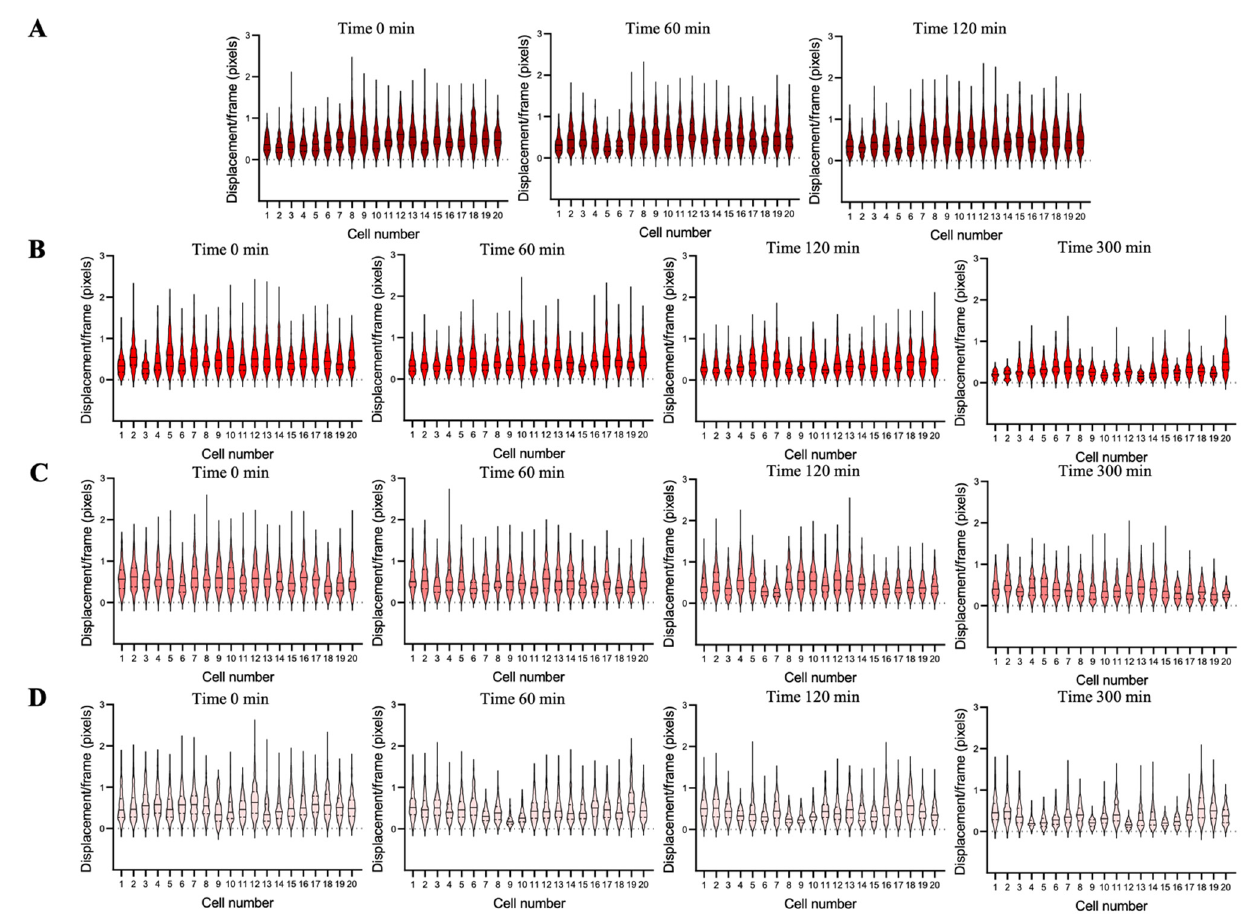
Figure 9. The displacement distribution for 20 single cells of C. albicans CAF2-1 wild-type strain displayed in violin plots during ( A ) 2 h of growth in a YPD medium (control) and during 5 h of treatment with the antifungal caspofungin at ( B ) 0.5 µg/mL, ( C ) 1 µg/mL, and ( D ) 100 µg/mL.